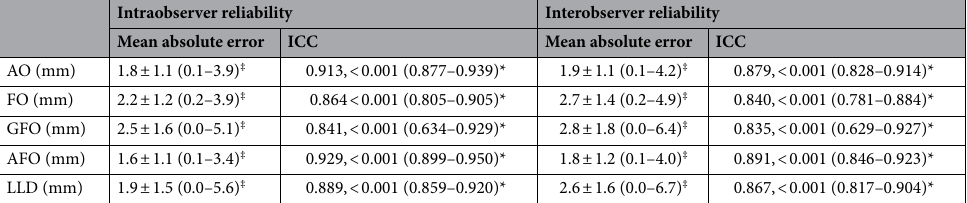
Table 4. Reliability of the measurement values. ICC intraclass correlation coefficient, AO acetabular offset, FO femoral offset, GFO global femoral offset, AFO anterior femoral offset, LLD leg length discrepancy. ‡ Mean ± standard deviation (range). *ICC, p -value (95% confidential